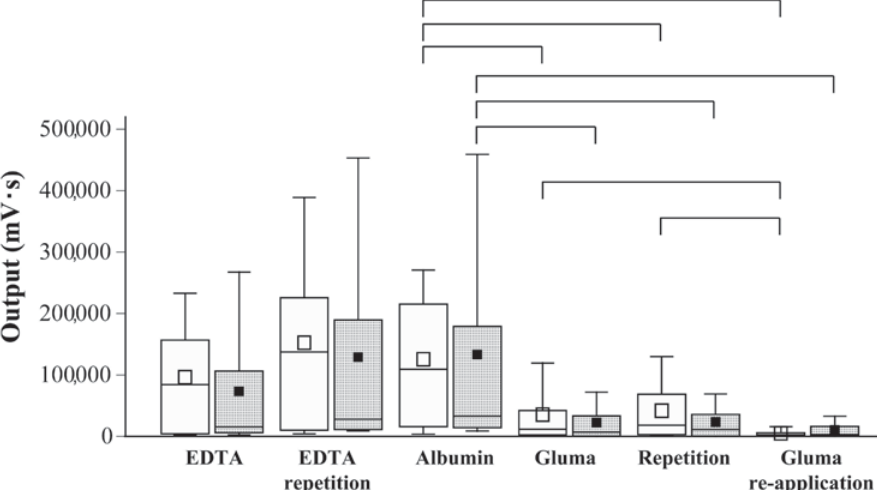
Figure 3- (cid:2)(cid:3)(cid:4)(cid:5)(cid:6)(cid:4)(cid:7)(cid:8)(cid:9)(cid:10)(cid:9)(cid:11)(cid:12)(cid:2)(cid:13)(cid:14)(cid:2)(cid:15)(cid:4)(cid:16)(cid:11)(cid:9)(cid:16)(cid:2)(cid:15)(cid:9)(cid:17)(cid:18)(cid:17)(cid:2)(cid:19)(cid:16)(cid:20)(cid:21)(cid:22)(cid:23)(cid:24)(cid:2)(cid:4)(cid:25)(cid:26)(cid:5)(cid:4)(cid:17)(cid:17)(cid:4)(cid:15)(cid:2)(cid:7)(cid:17)(cid:2)(cid:9)(cid:16)(cid:11)(cid:4)(cid:27)(cid:5)(cid:7)(cid:11)(cid:4)(cid:15)(cid:2)(cid:13)(cid:28)(cid:11)(cid:26)(cid:28)(cid:11)(cid:2)(cid:13)(cid:14)(cid:2)(cid:18)(cid:29)(cid:4)(cid:6)(cid:9)(cid:10)(cid:28)(cid:6)(cid:9)(cid:16)(cid:4)(cid:17)(cid:18)(cid:4)(cid:16)(cid:18)(cid:4)(cid:2)(cid:19)(cid:6)(cid:30)(cid:31)(cid:17)(cid:23)(cid:2)(cid:28)(cid:16)(cid:15)(cid:4)(cid:5)(cid:2)!"#(cid:2) kPa pressure at different treatment and evaluation stages. EDTA: samples cleaned for smear on both saw-cut surfaces;